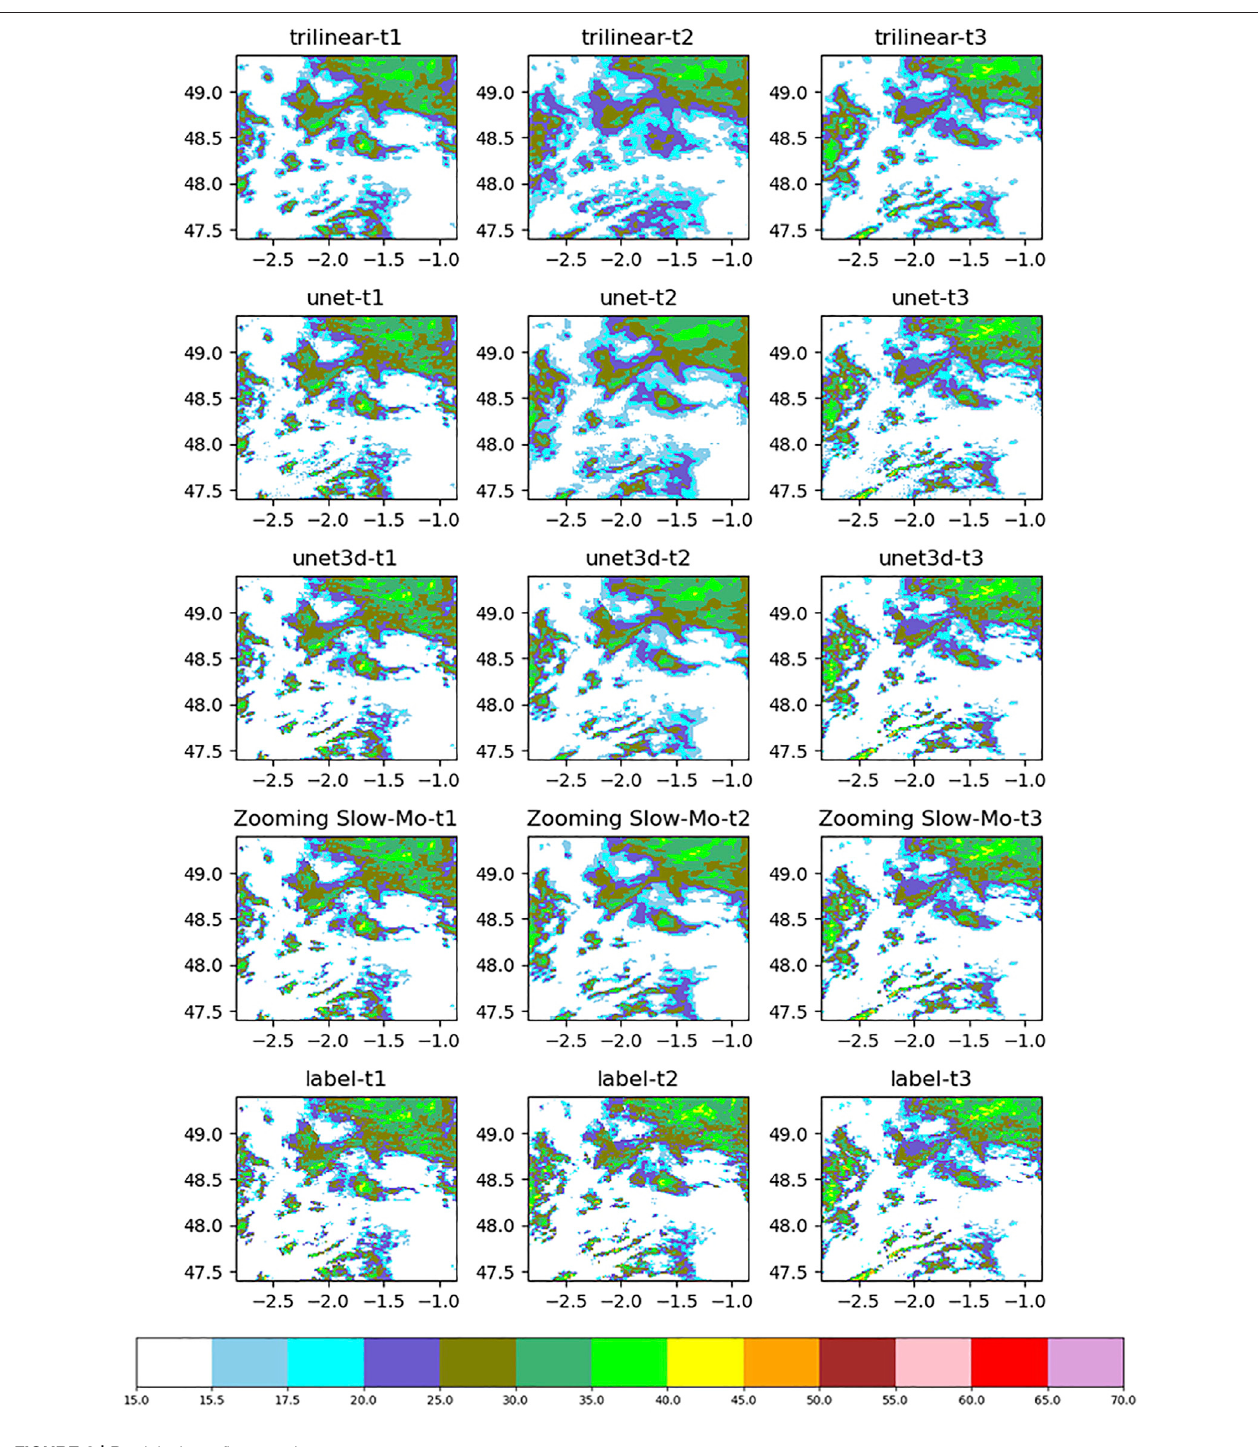
FIGURE 8 | Precipitation re fl ectance